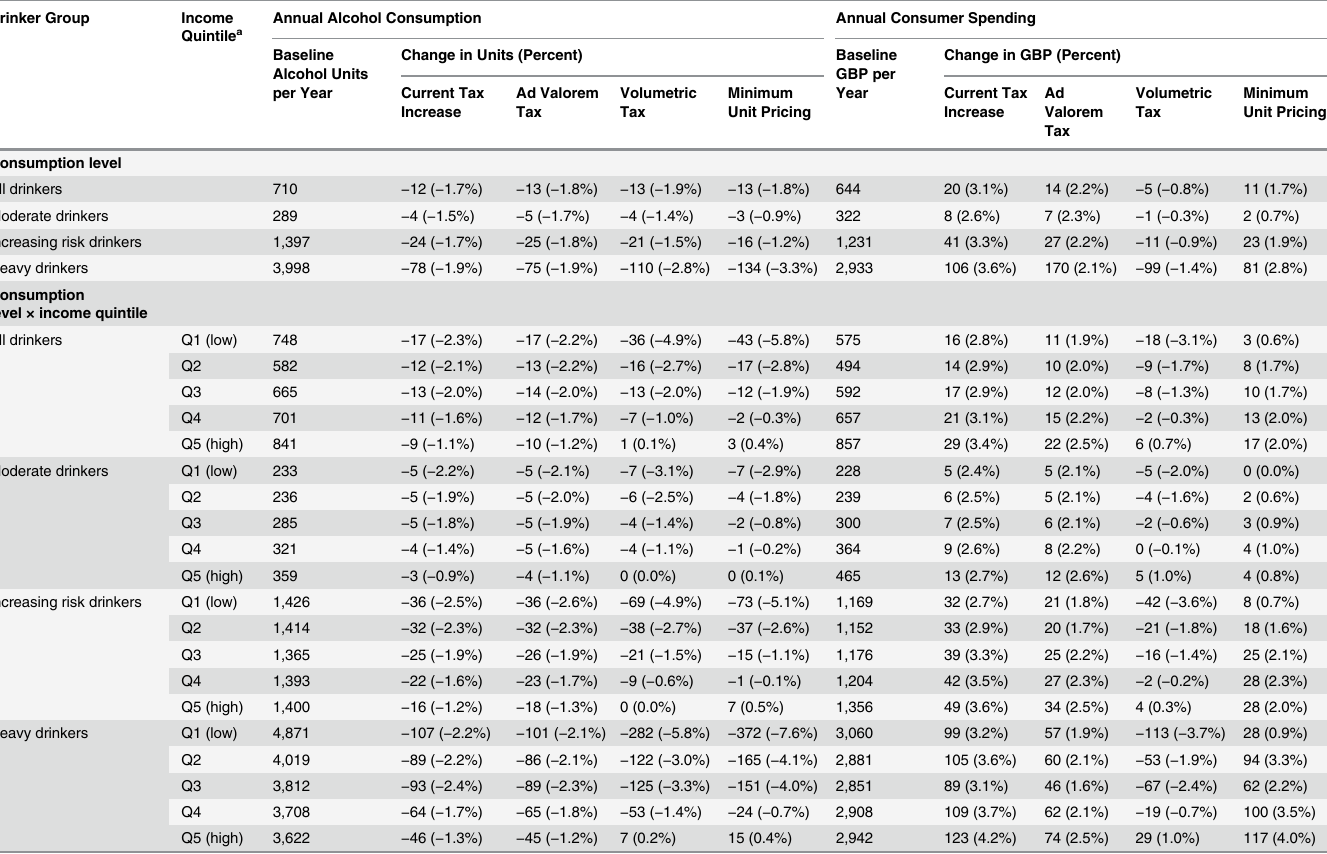
Table 4. Policy effects on alcohol consumption and consumer spending, by drinking level and income